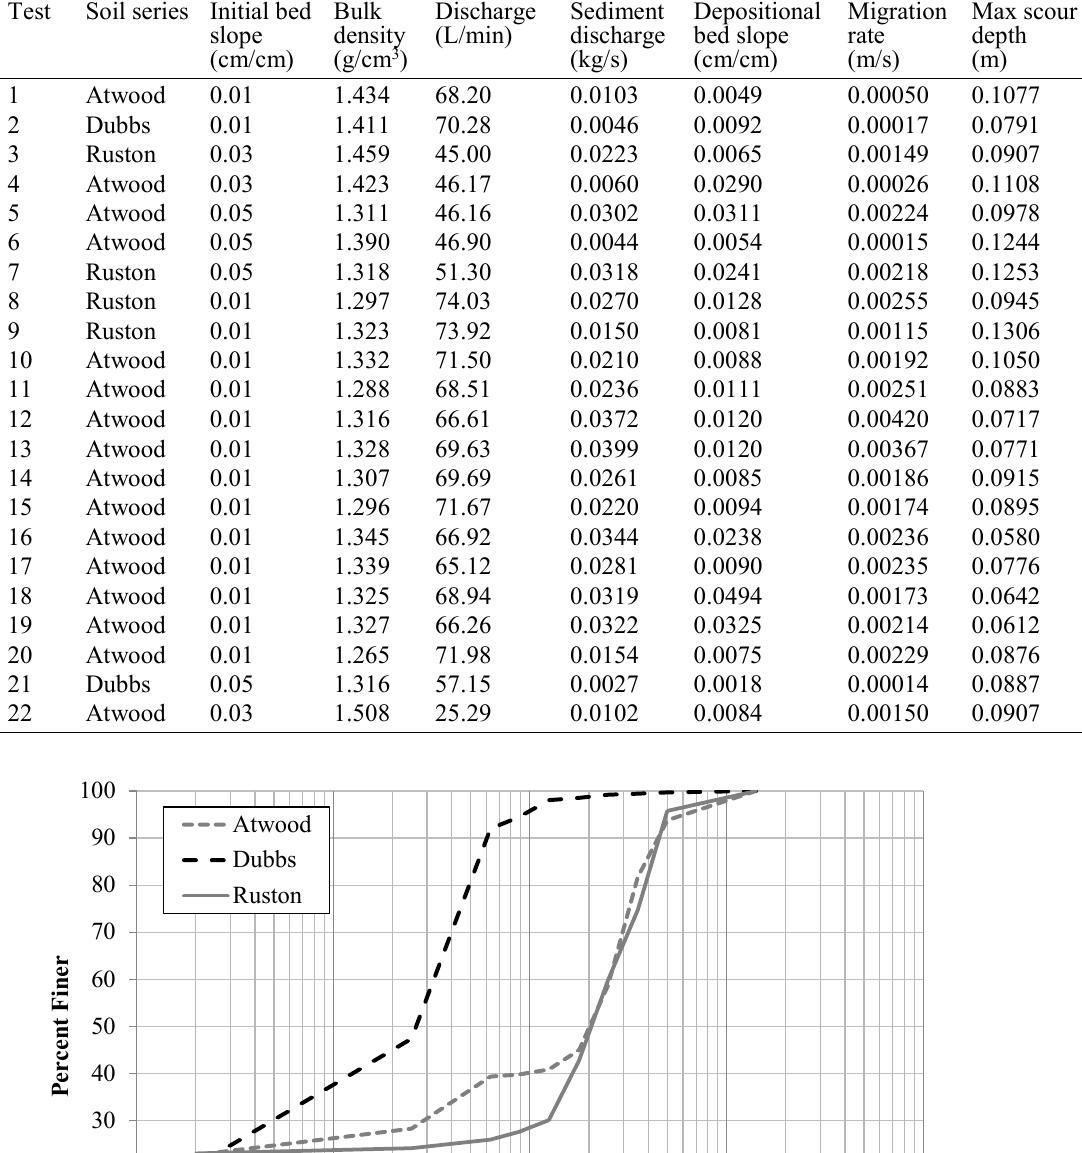
Table 1 Summary of experiments used to evaluate sediment transport capacity equations.